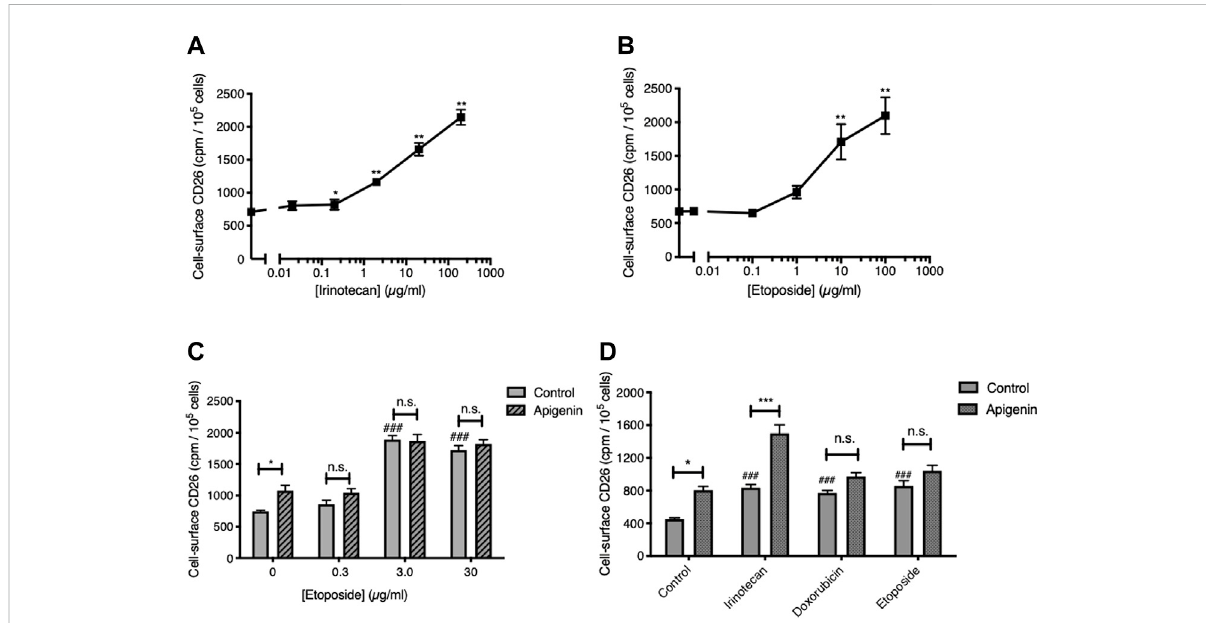
FIGURE 2 Topoisomerase 2 inhibitors elevate CD26 but do not reproduce the interaction with apigenin. (A,B) Topoisomerase 1 and 2 inhibitors both enhance cell-surface CD26. HT-29 cells treated for 48 h. Means ± SE ( n = 4), one-way ANOVA followed by Dunnett ’ s test; * p < 0.05 and ** p < 0.01, enhancementinCD26bytopoisomeraseinhibitors. (C) Apigenindoesnotenhancetheactionorpotencyofetoposide.Means+SE( n =4);* p < 0.05, enhancementby apigenin(30 µM); ### p < 0.001 up-regulation by etoposide. (D) Apigenininteractssolely with the Topo1 inhibitor